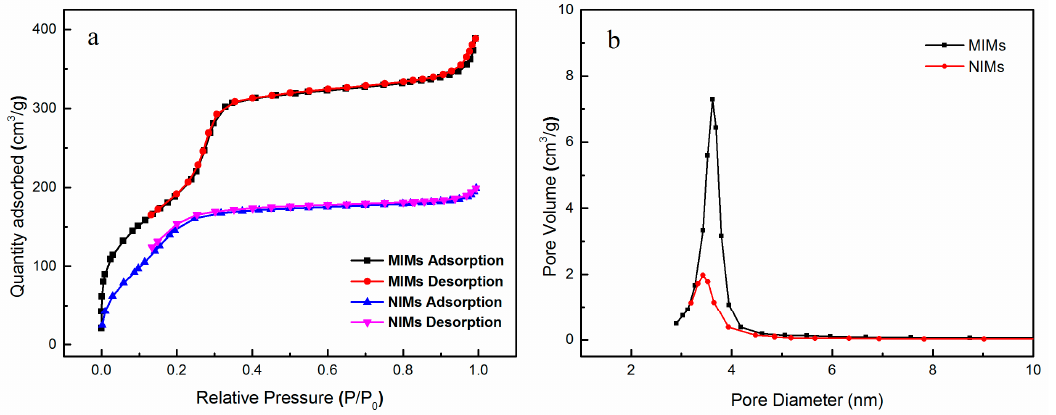
Figure 3. N 2 adsorption–desorption isotherms ( a ) and pore size distribution ( b ) for molecularly imprinted mesoporous materials (MIMs) and non-imprinted mesoporous materials (NIMs).